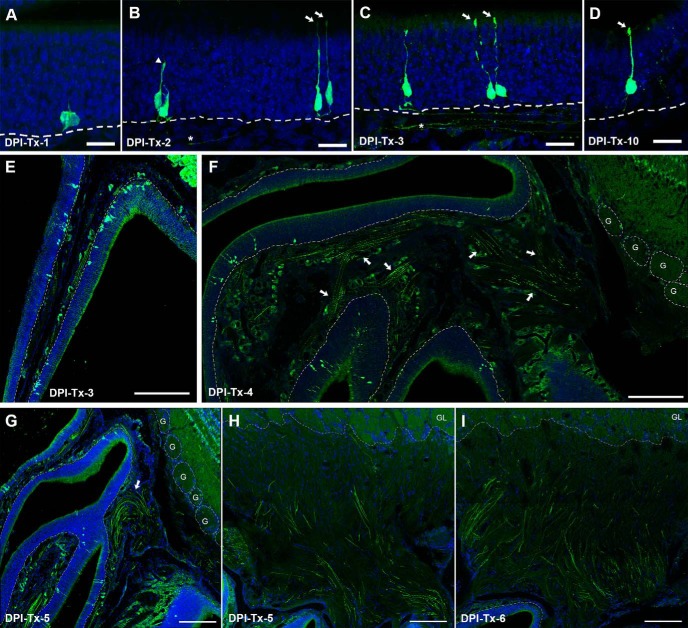
In vivo genetic fate-mapping strategy reveals spatiotemporal morphologic features of P25-born OSNs. A–D, ZsGreen+ cell bodies migrate radially toward the surface of the OE during a 12 d time course following basal cell division, revealing that most of them are differentiated as OSNs with characteristic morphologic features. OSN apical dendrites and axons can be detected as early as 2 d following 4OH-Tx injection (B–D), but not earlier (A). E–H, ZsGreen+ axons form fascicles starting at 3 d following 4OH-Tx injection (E) and travel toward the OB (F), and cross the cribriform plate at DPI-Tx-4/5 (G, arrow), and some of them reach the oONL as early as DPI-Tx-5 (H). I, By DPI-Tx-6, the oONL is heavily innervated by ZsGreen+ axons. DRAQ-5 is in blue. Dashed white lines delineate the basal lamina in A–G, and the limit between the glomerular layer (GL) and the ONL in H. Dotted circles delineate glomeruli in G, and each glomerulus is designated by the letter “G.” Scale bars: A–D, 20 μm; E, F, H, I, 200 μm; G, 300 μm.